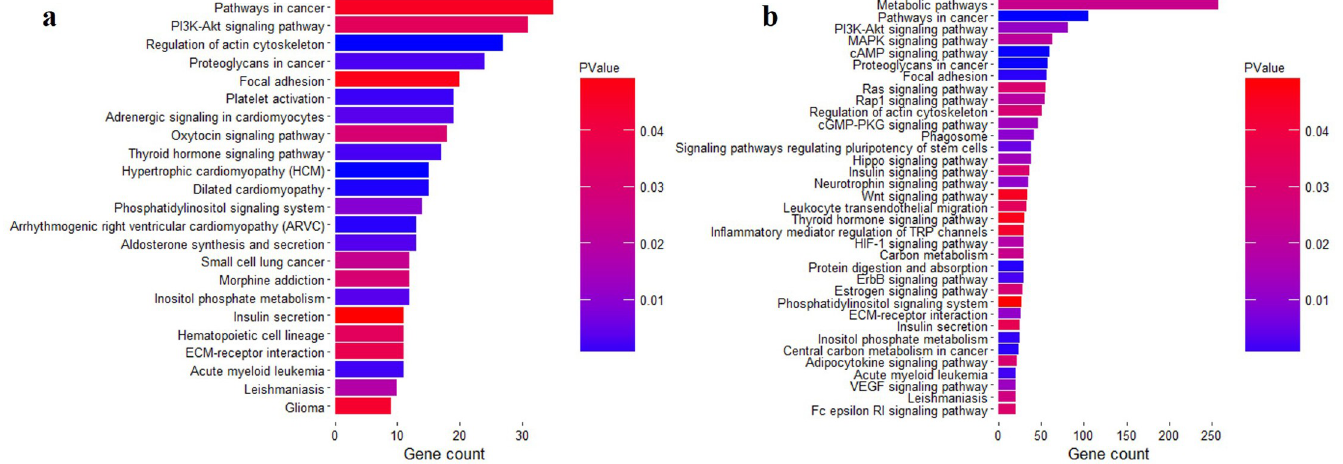
Fig 7. KEGG enrichment analysis of DNA methylation changes. ( a ) The significantly enriched signaling pathway of genes associating with CpG methylation changes. ( b ) The significantly enriched signaling pathway of genes associating with CpH methylation changes.